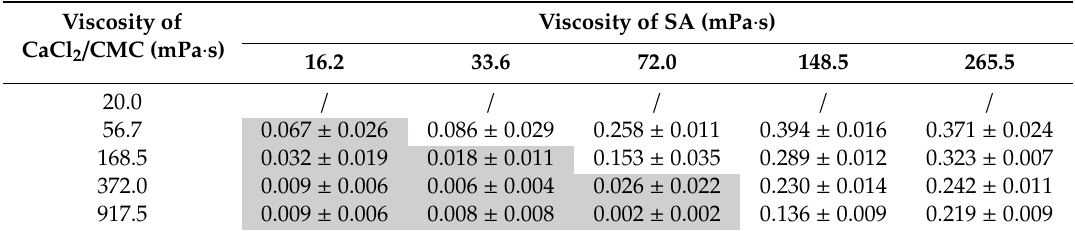
Table 1. E ff ects of viscosity of SA and CaCl 2 / CMC solutions on the sphericity factor ( SF ) of mm-CaSA-Caps.